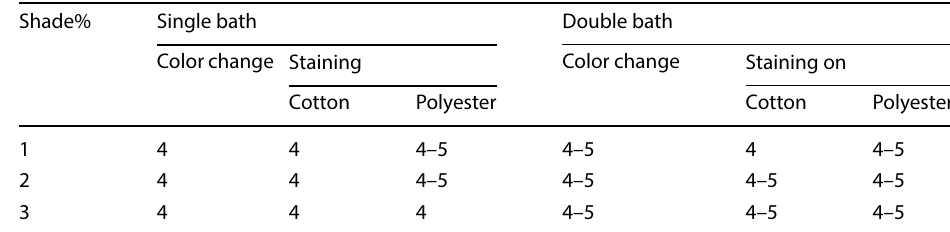
Table 4 Wash fastness properties of modified PC blend and conventional fabric dying